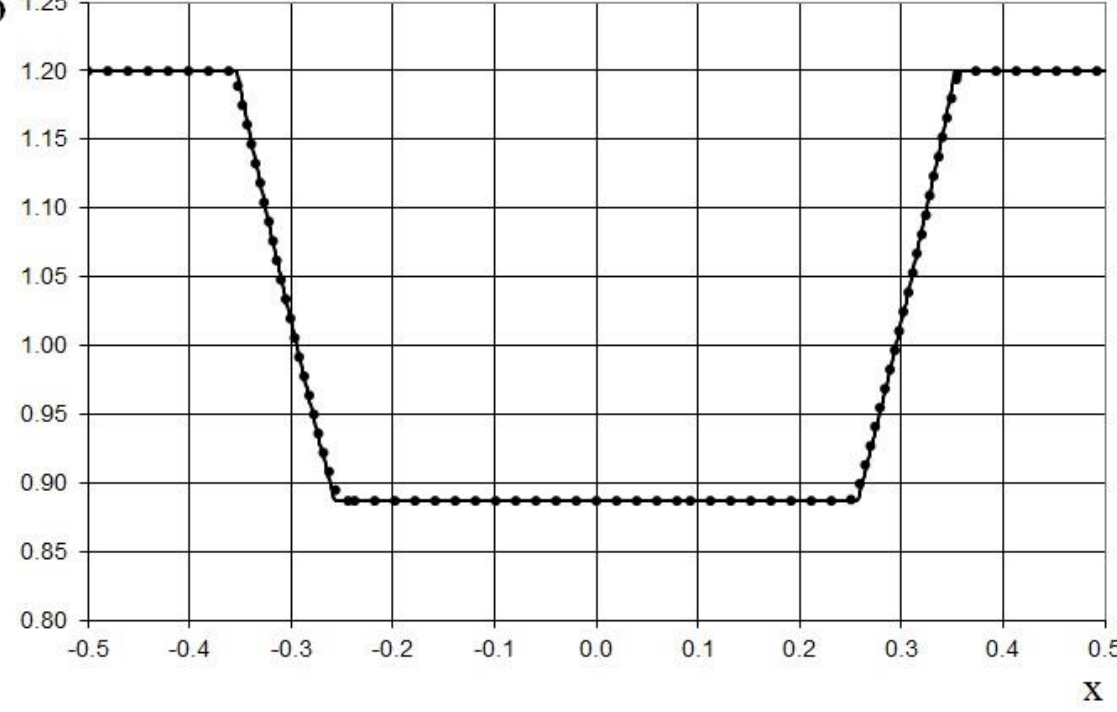
Figure 20. Density plot for the double expansion wave problem (47) for the one-dimensional scalar hyperbolic conservation law, using the finer grid (1000 grid points): the exact solution (solid line), and the present method (dotted line).